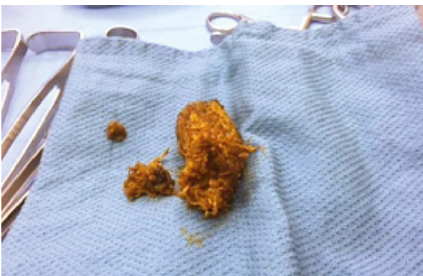
Figure 2: Intraoperative photograph of the bezoar. A longitudinal enterotomy was performed to evacuate the phytobezoar, which measured 4cm by 3cm in diameter, and consisted of fibrous vegetable matter and acellular